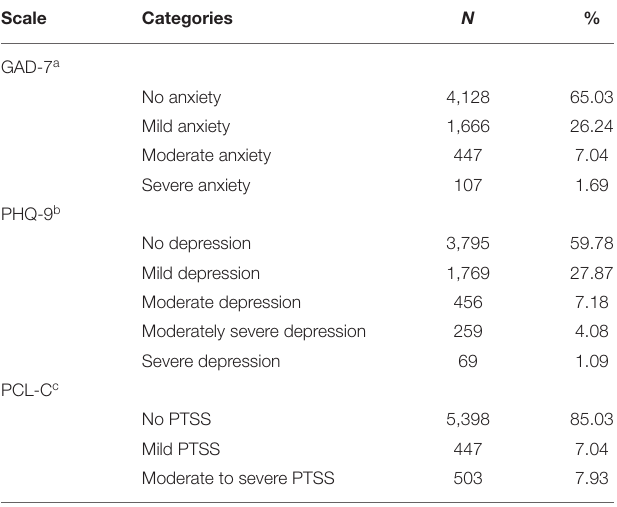
TABLE 2 | Prevalence of anxiety, depression and PTSS at different levels among nursing students.